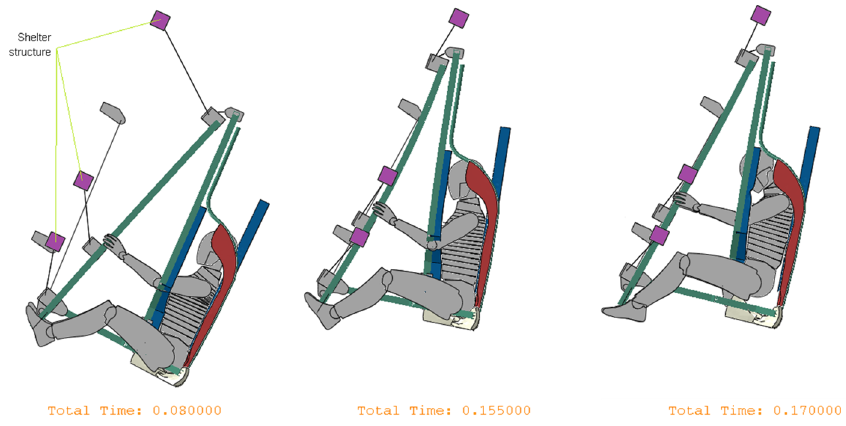
Figure 11. Impact against UPN 100 ′ s profiles’ bumpers (situation 2, “lower” chair).